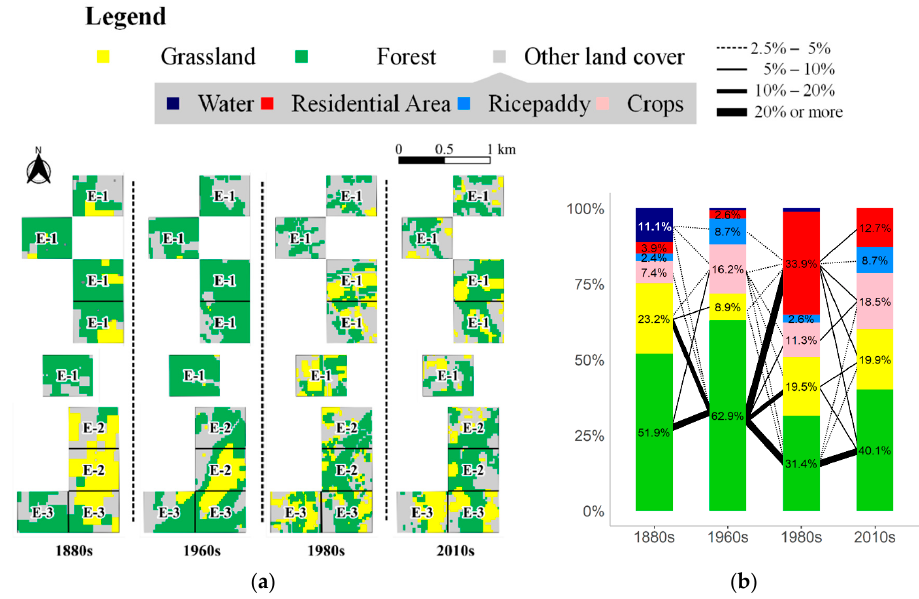
Figure 7. The time series land cover map and changes in land cover types in the grids that belong to research institutions. ( a ) shows the land cover map between the 1880s and 2010s focused on the natural environments (Forest and Grassland). ( b ) shows the changes in land cover types between the 1880s and 2010s. The value in each bar represents the percentage (%) of each land cover type. The connecting line between two bars indicates the change in land cover type through the periods. The thickness of the line corresponds to the proportion of the changed area with respect to the grids shown in ( a ). The line was omitted if the proportion is less than